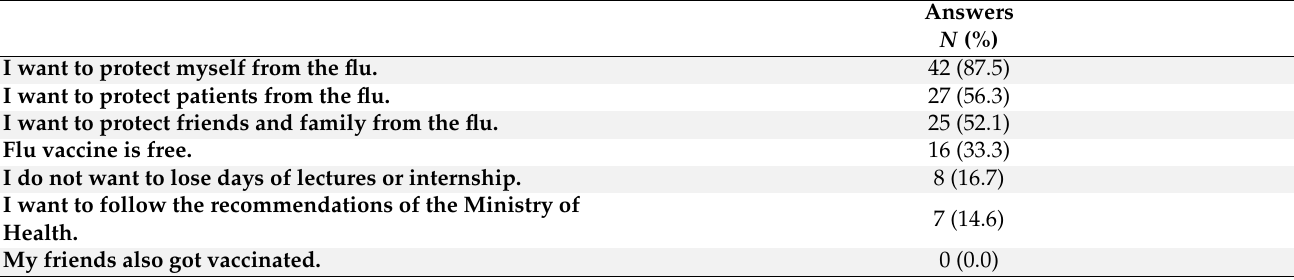
Table 2. Reasons for accepting flu vaccination ( n = 48).